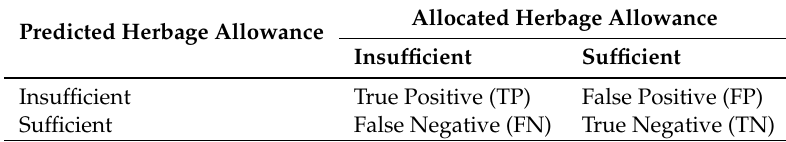
Table 3. Confusion matrix for estimating the classification evaluation metrics based on the number of actual and predicted classes among the test cases.